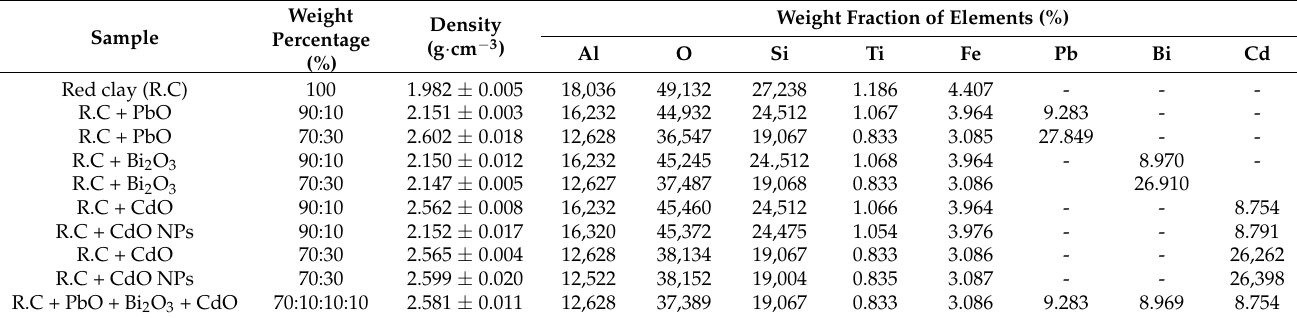
Table 1. Chemical composition and densities of prepared ceramic-based red clay samples. Sample